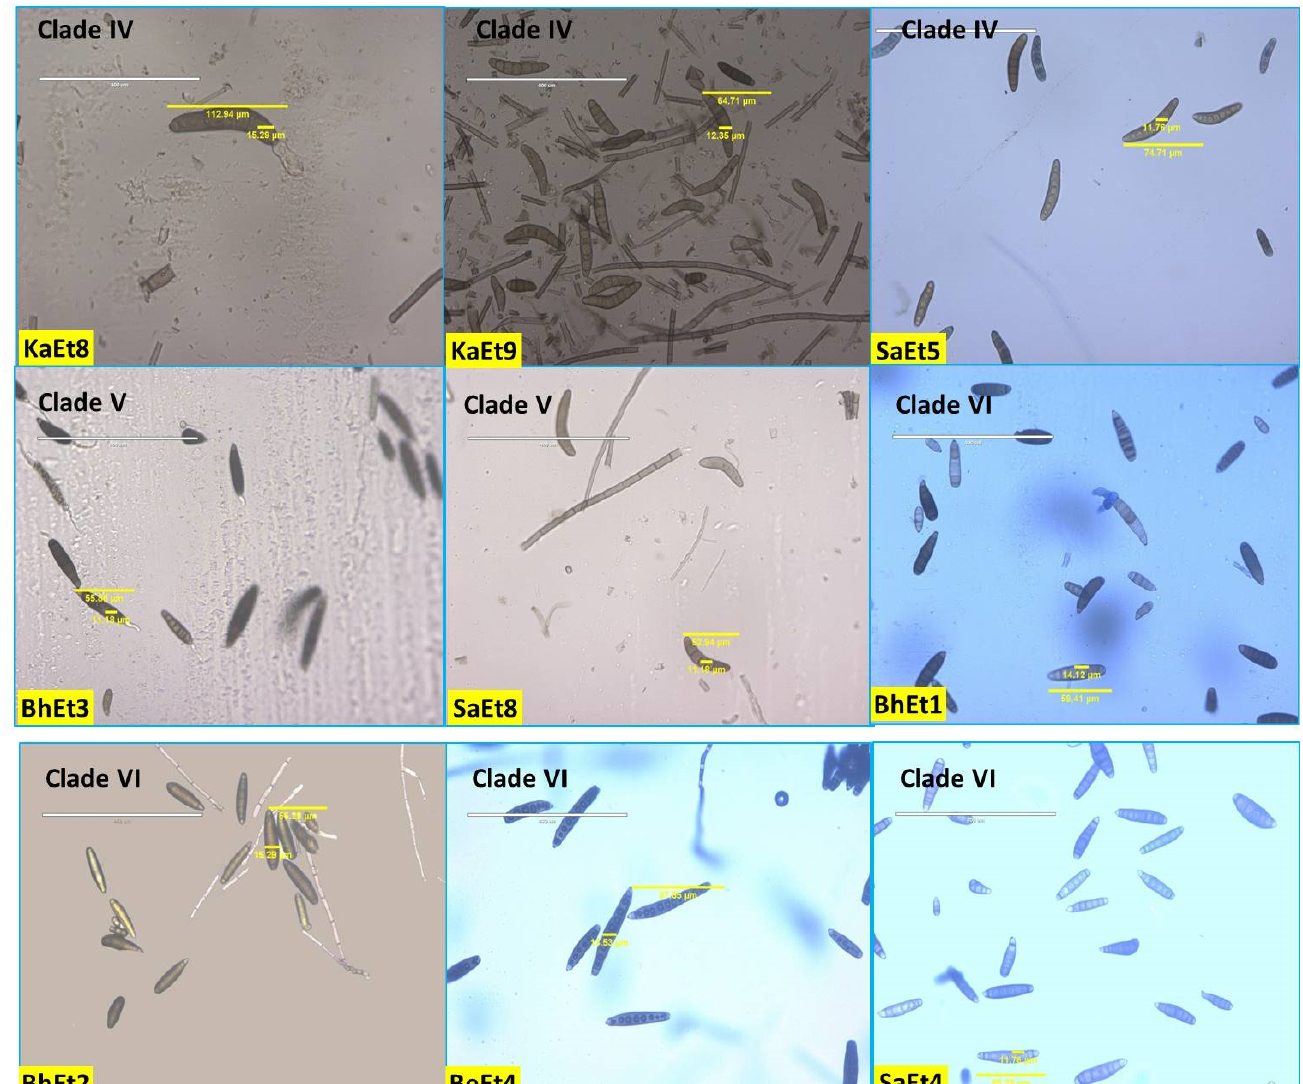
Figure 3. Conidial variability of different isolates of E. turcicum causing NCLB. Based on the conidial color, all the E. turcicum isolates were classified into three groups, i.e., brown, dark brown, and olivaceous brown. The isolates BhEt1, BhEt4, BhEt6, BeEt6, KhEt1, KhEt5, KhEt6, KhEt9, KaEt1, KaEt3, KaEt4, KaEt5, SaEt3, SaEt4, SaEt8, and SaEt9 came under the group of conidia with brown color; the isolates BhEt2, BhEt3, BhEt7, BhEt8, BhEt9, BeEt2, BeEt4, BeEt7, KhEt2, KhEt3, KhEt4, KhEt7, KaEt6, SaEt1, SaEt2, SaEt5, and SaEt7 came under the group of conidia with dark brown color; and the isolates BhEt5, BeEt1, BeEt3, BeEt5, BeEt8, BeEt9, KhEt8, KaEt2, KaEt7, KaEt8, KaEt9, and SaEt6